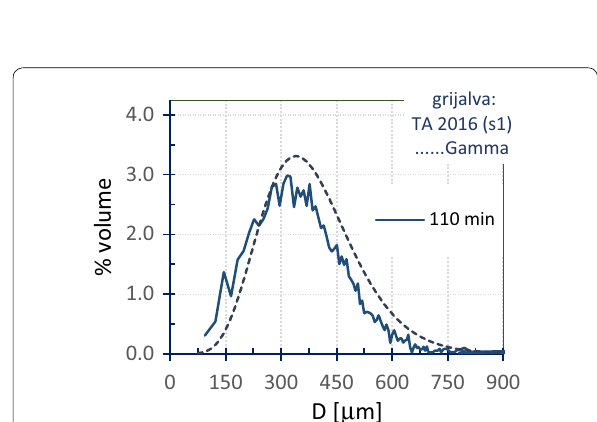
Fig. 8 Floc size variation in time with PTV during RAF experiments for the Usumacinta river